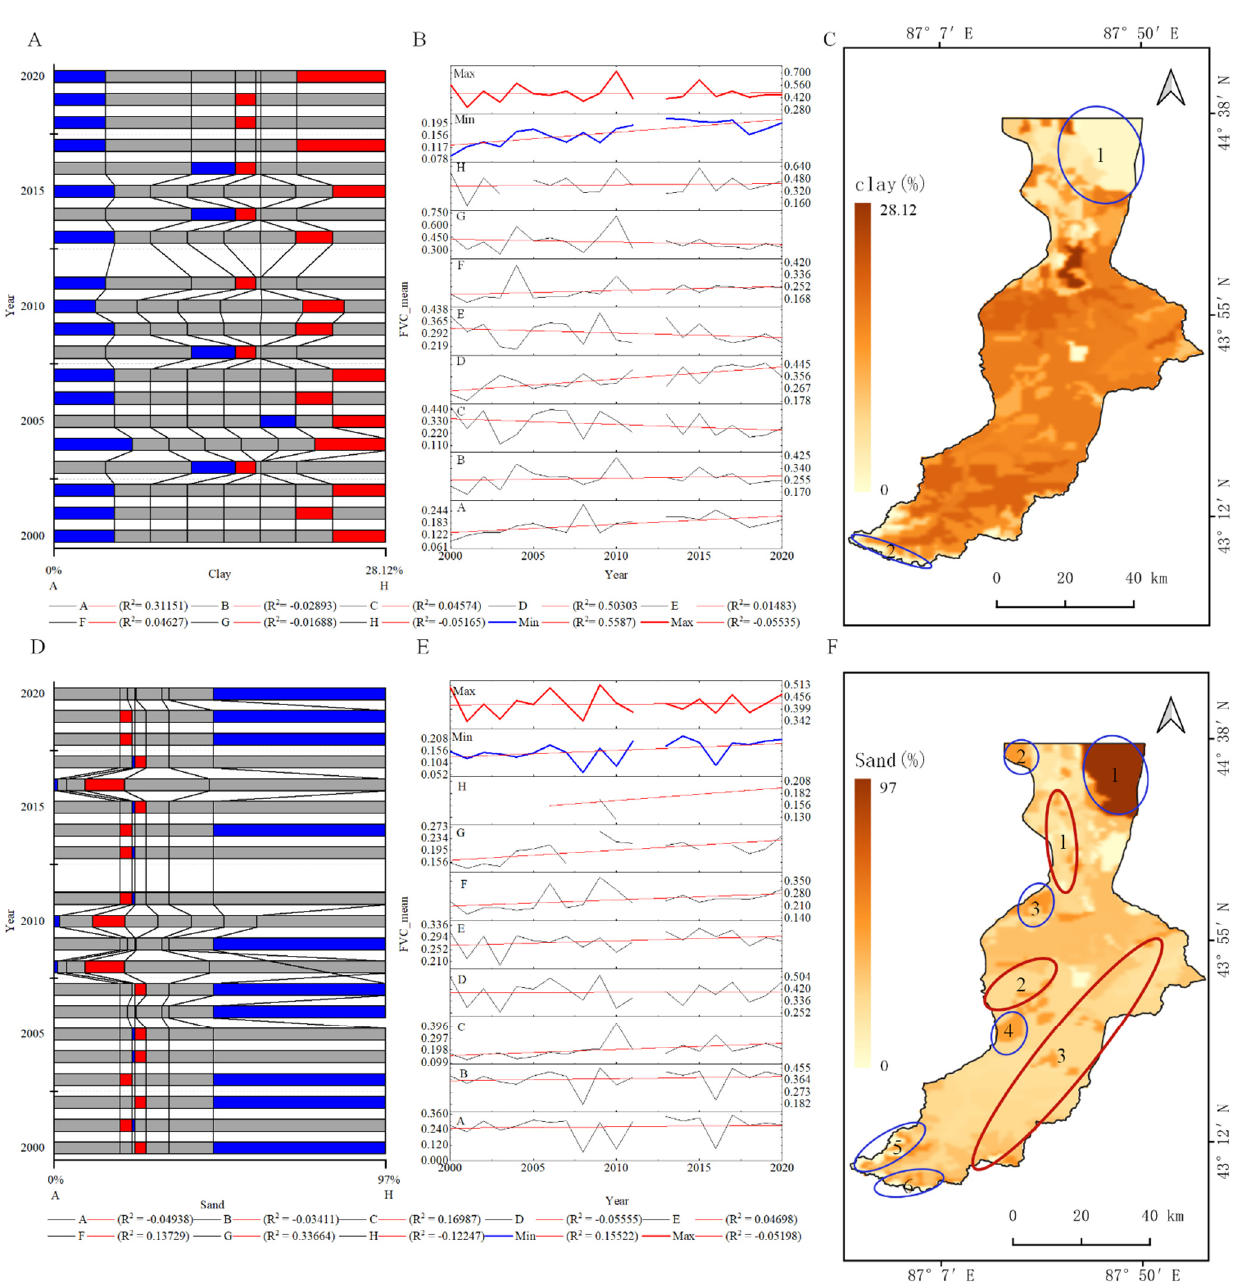
Figure 10. Analysis of the soil characteristic risk area based on the OPGD model: ( A ) soil clay content risk areas; ( B ) FVC mean values for each soil clay content risk areas; ( C ) spatial distribution of soil clay content; ( D ) soil sand content risk areas; ( E ) FVC mean values for each soil sand content risk areas; ( F ) spatial distribution of soil sand content; (red line) maximum FVC mean value in risk area; (blue line) minimum FVC mean value in risk area.